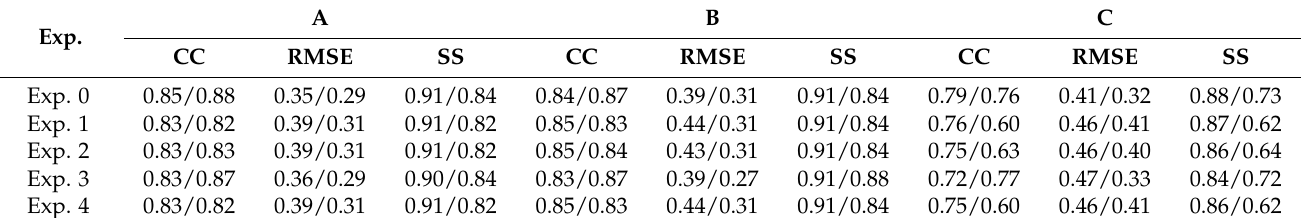
Table 2. Model validation statistics of flow velocity at the observational sites (value at surface layer/value at bottom layer). Exp.